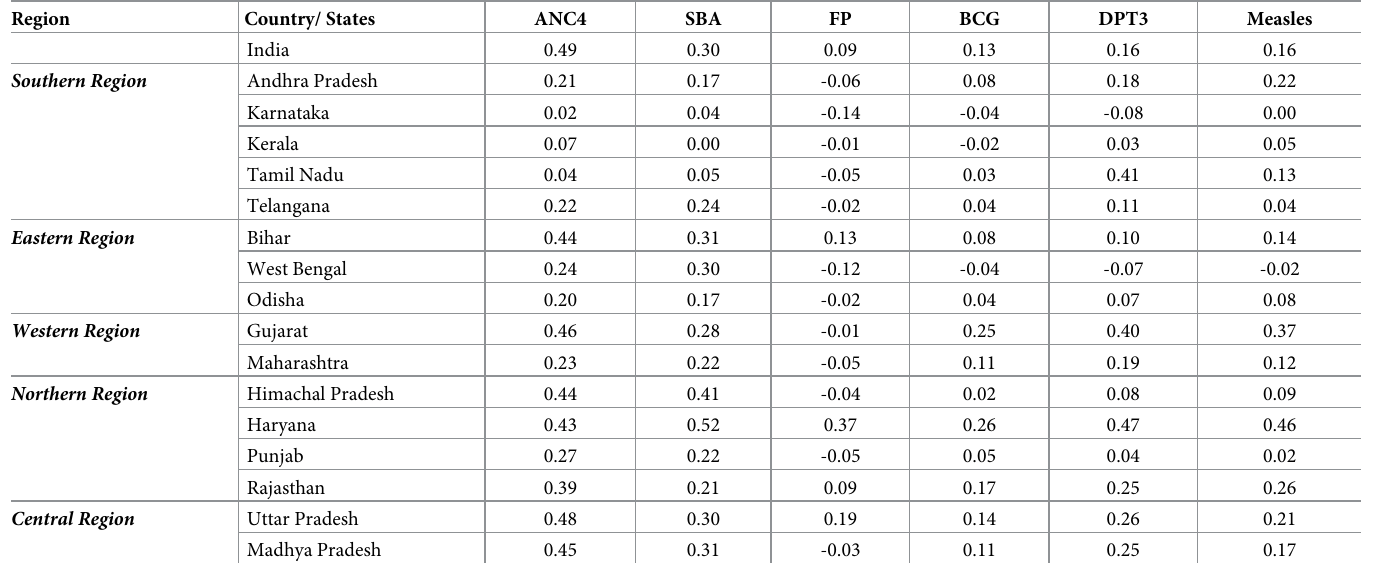
Table 5. Absolute gap in RMNCH coverage indicators across major